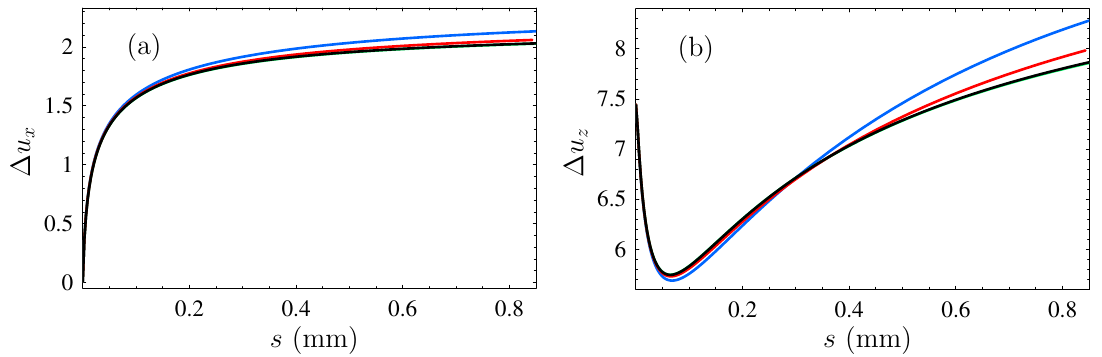
FIG. 19. (Color) Comparison between the reduced 3D-PPI model and the electrostatic PIC for the case of a large energy spread beam with an exponential energy profile. Input parameters: Charge Q (cid:1) 5 nC , temperature k (cid:1) 10 (cid:4) m , and divergence x 0 (cid:1) 2 mrad . In (black) PPI with N (cid:1) 20032 macroparticles, cutoff radius r a max 3 (cid:1) 422 nm , (green) electrostatic PIC with N (cid:1) 10 : 24 (cid:5) 10 6 macroparticles and grids 128 2 (cid:5) 512 , (red) macroparticle distance n (cid:6) 1 = 3 0 electrostatic PIC with N (cid:1) 20 : 48 (cid:5) 10 6 macroparticles and grids 256 3 , and (blue) electrostatic PIC with N (cid:1) 2 : 56 (cid:5) 10 6 macro- particles and grids 128 3 . Evolution of (a) transverse RMS momentum spread (cid:1) u a function of propagation distance s is